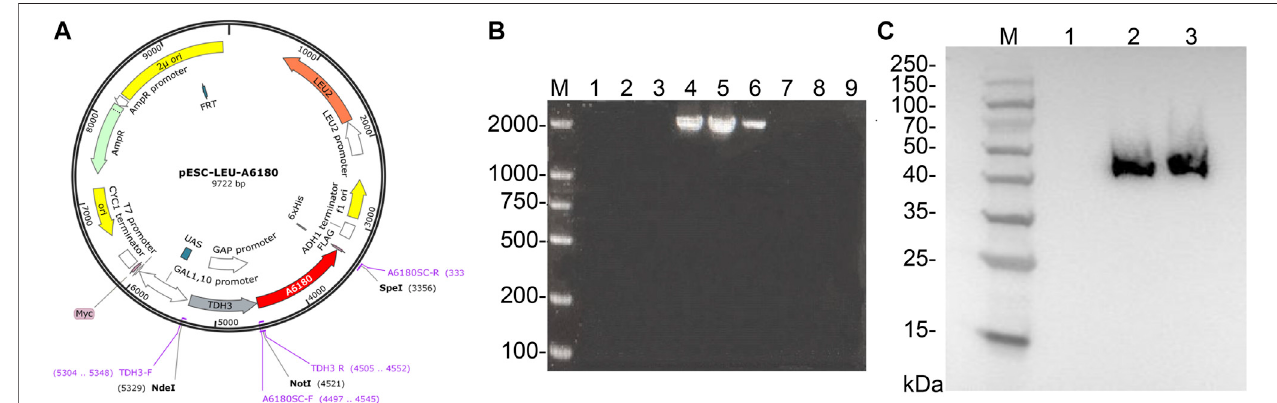
FIGURE 5 | Expression of A6180 in yeast. (A) Schematic diagram of the construction of recombinant overexpression vector pESC-Leu-A6180. (B) Veri fi cation for positivetransformantsofyeast.M: D2000Marker; 1 – 3: blankcontrols;4 – 9:transformants1 – 6. (C) Westernblot resultsofpositivetransformants.M:Prestainedprotein Marker 10 – 180 kDa; 1: Parent strain. 2 – 3: Positive